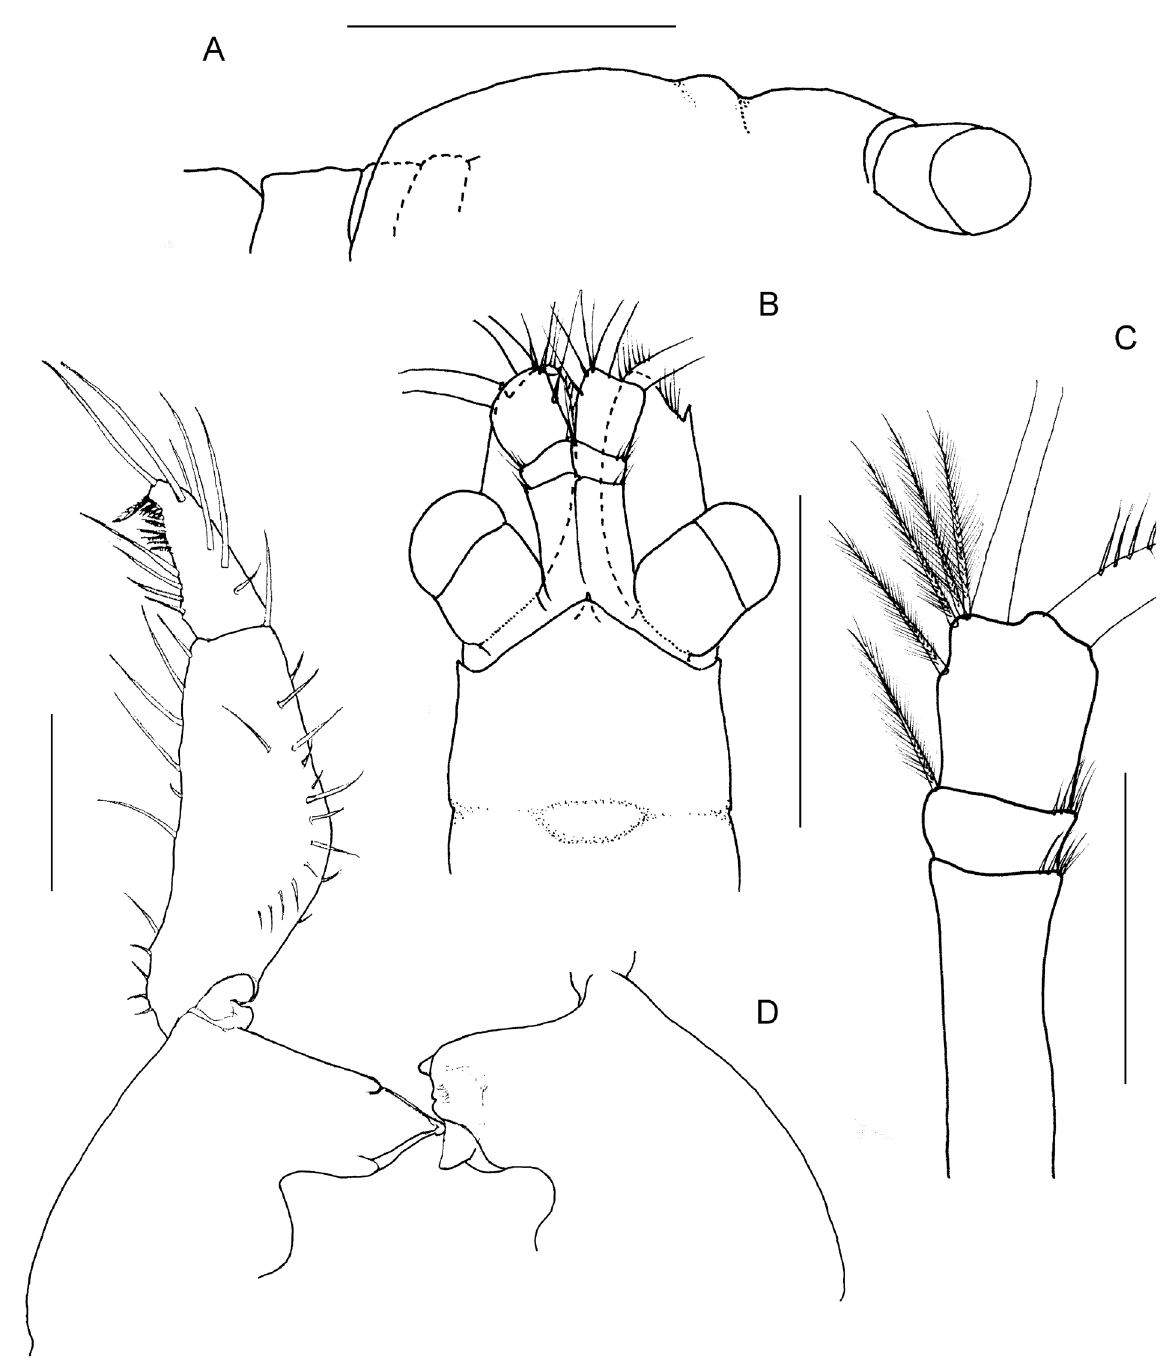
Fig. 21. Siriella occulta sp. nov., paratype, ♀, length 5 mm, Arabian Gulf, Saudi Arabia. A . Dorsal part of carapace, lateral view. B . Anterior part of body, dorsal view. C . Peduncle of antenna 1, dorsal view. D . Mandibles with mandibular palp, posterior view. Scale bars: A–B = 1 mm; C = 0.5 mm; D = 0.1